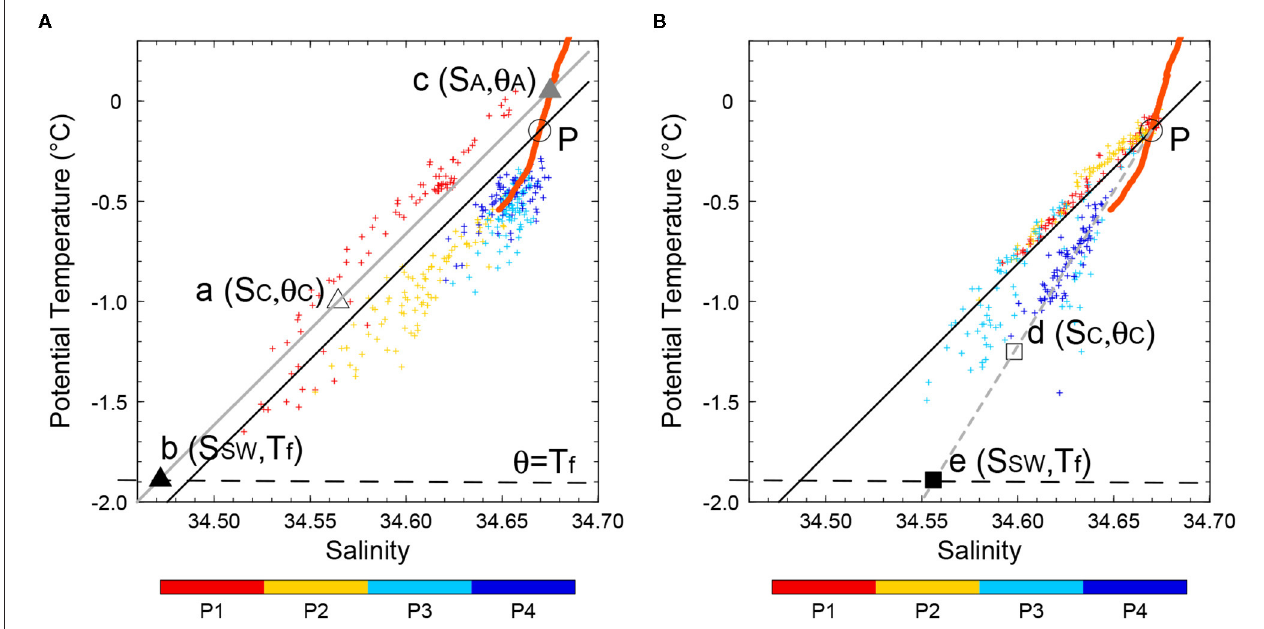
FIGURE 9 | Schematic showing how to determine mixing lines, S SW , S A , and θ A . The solid line indicates a line passing through the point P (circle). The thick orange line indicates a θ - S curve for CTD station c05. The long dashed line indicates the freezing line, θ = T f . The gray line in (A) indicates the mixing line for CDBW located at point a (triangle). This CDBW is formed by the mixing of SW located at point b (black triangle) with ambient water located at point c (gray triangle). The dashed gray line in (B) indicates the mixing line for CDBW located at point d (square). This CDBW is formed by the mixing of SW located at point e (solid square) with ambient water located at point P. As in Figure 8B , the pluses with colors in (A,B) indicate ( S , θ ) data obtained by the deepest CT sensor at moorings M2 and M4, respectively. The details are discussed in the text.